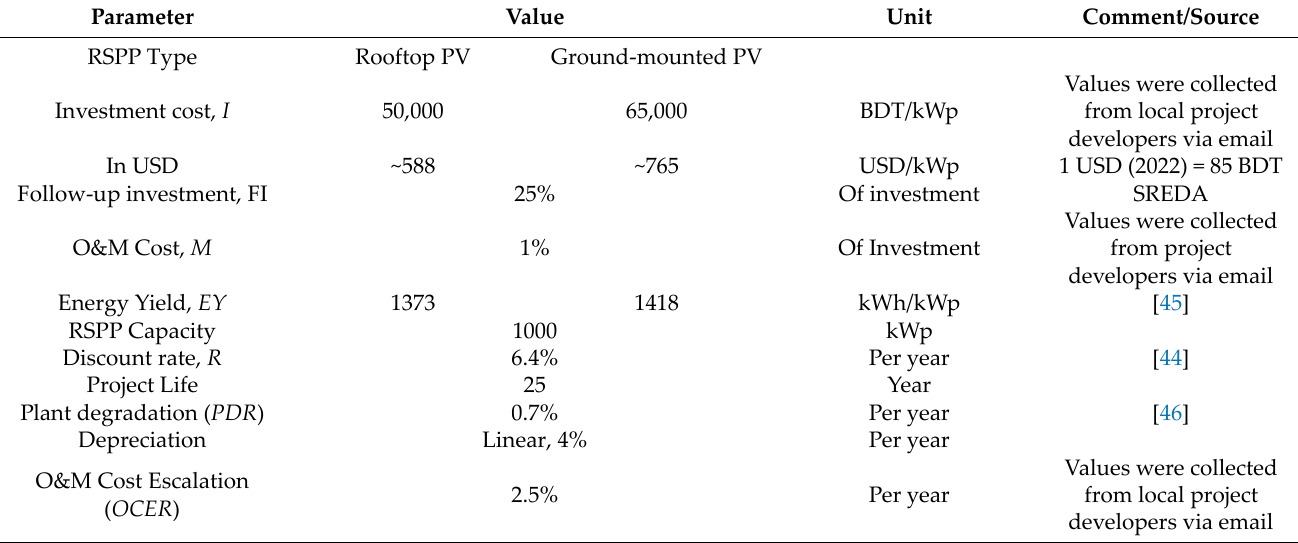
Table 2. Input parameters for RSPP LCOE